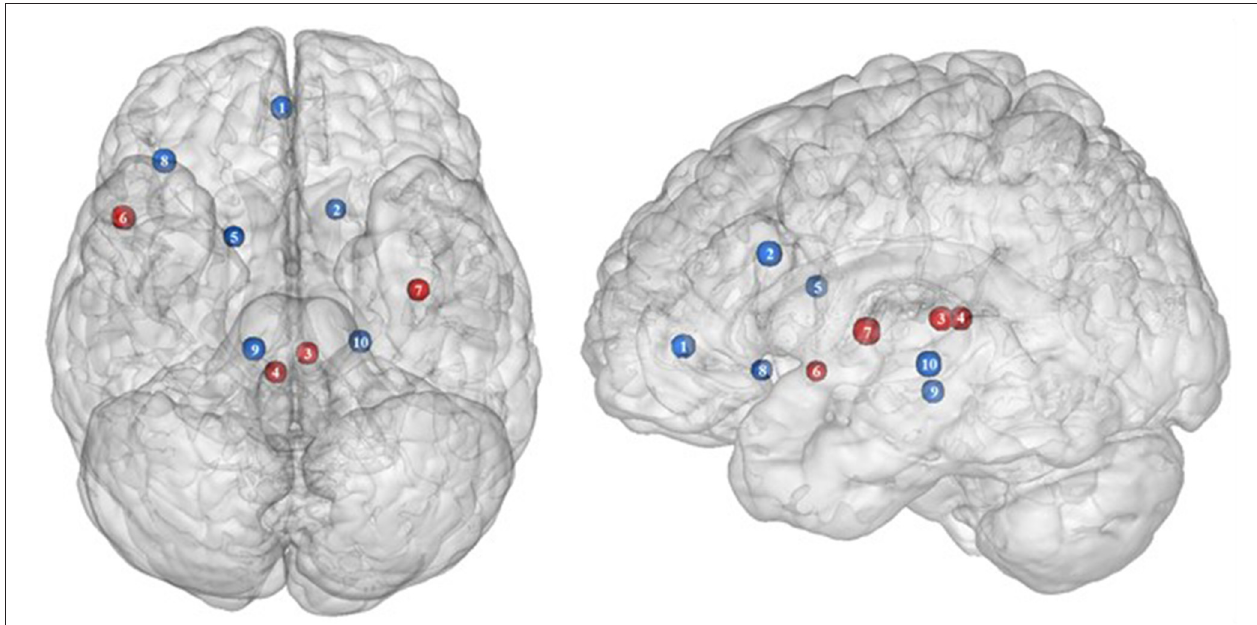
FIGURE 3 | Functional activity in the limbic regions during inhibition. Blue and red colors indicate hypo- and hyperactivity, respectively, in obese in comparison with lean participants during inhibition (see Table 3 for precise coordinates). 1 = anterior cingulate cortex (46), 2 = anterior cingulate cortex (53), 3–4 = posterior cingulate cortex ( 53), 5 = dorsal caudate nuclei (53), 6 = insula (43), 7 = insula (32), 8 = insula (32), 9 = parahippocampal gyrus (49), 10 = thalamus (49).